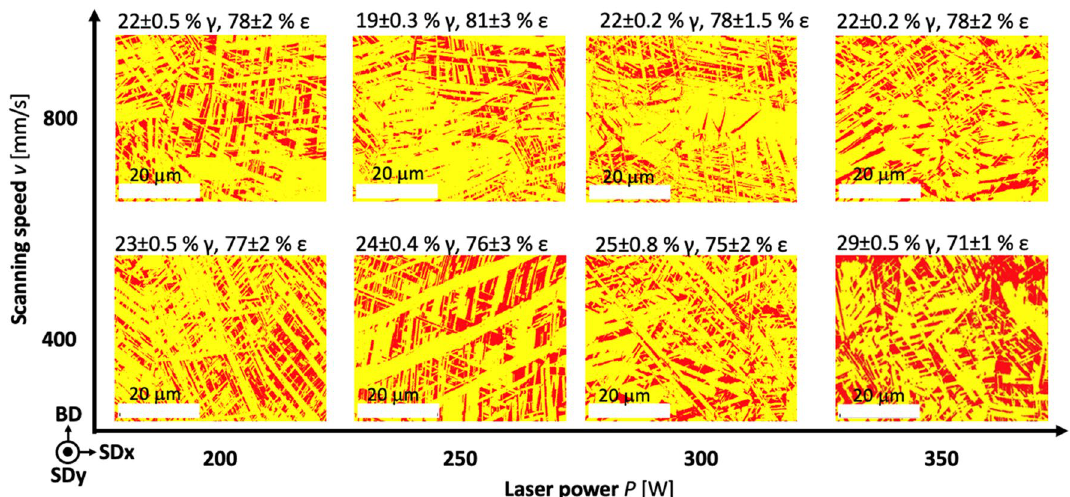
Figure 3. Phase maps of ε phase—yellow, and γ phase—red for LPBF samples produced at different process parameters.